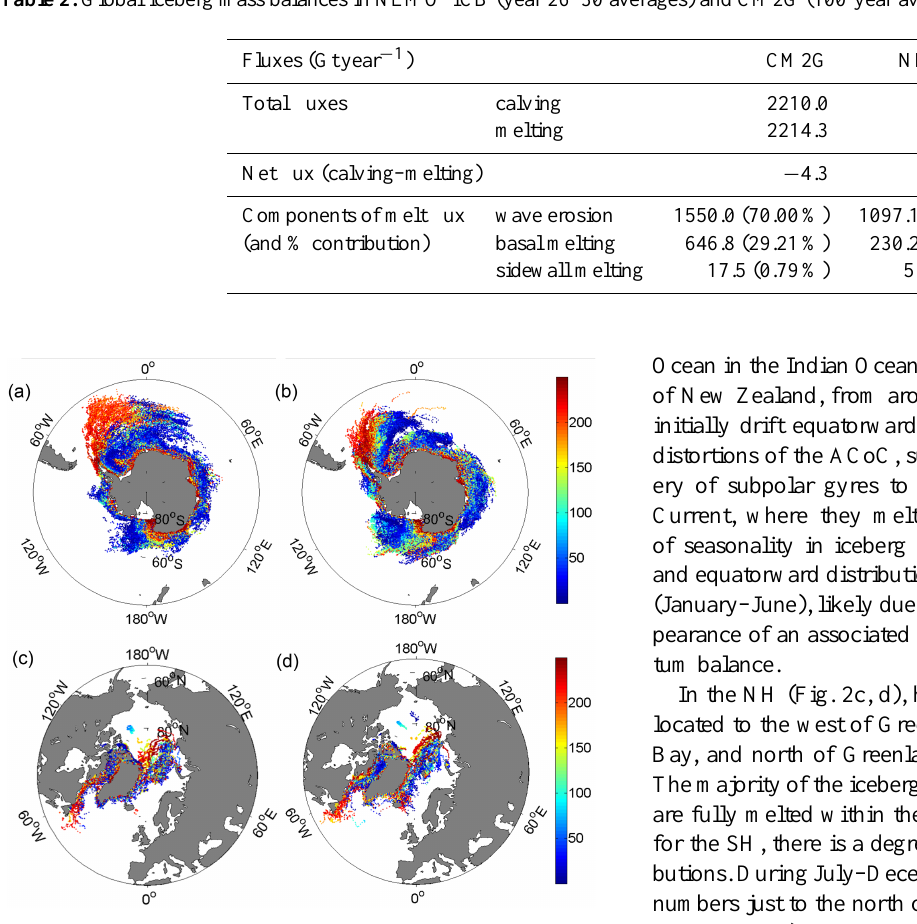
Figure 2. All iceberg positions, colour-coded for size class (or thickness), for the two seasons of year 30 in each hemisphere: (a) SH, January–June; (b) SH, July–December; (c) NH, January– June; (d) NH,